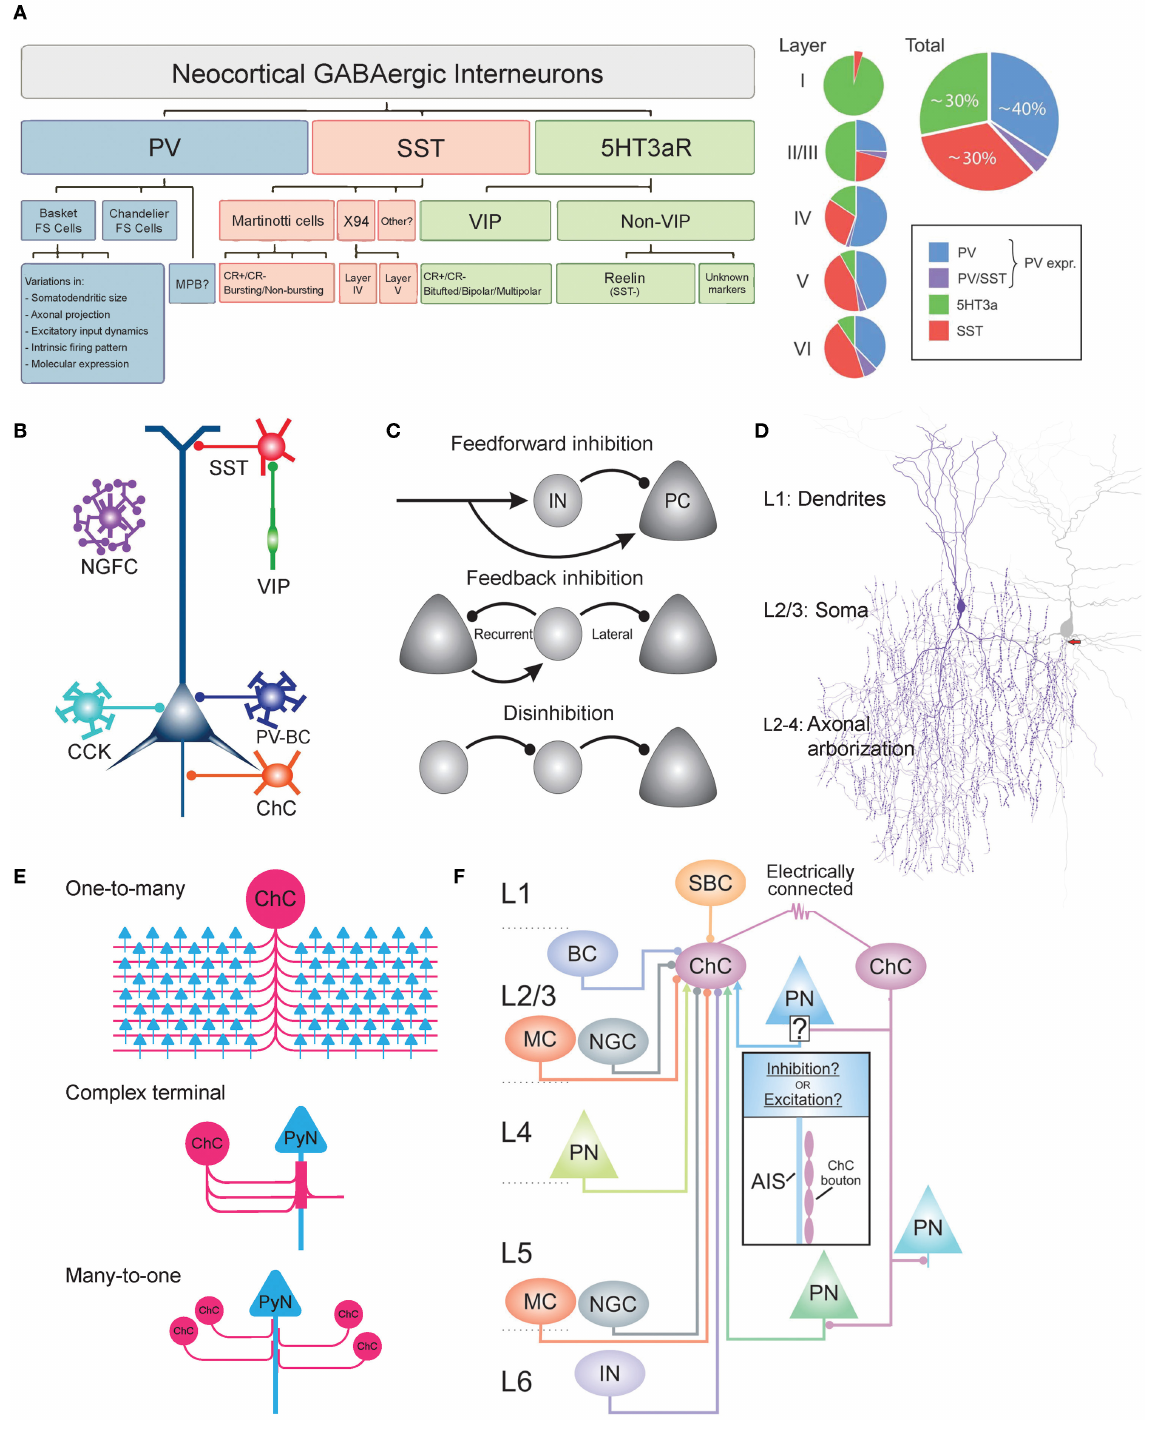
FIGURE1 Heterogeneity of GABAergic interneurons and connectivity of ChCs. (A) Dendrogram and Venn diagram of neocortical GABAergic interneurons. Parvalbumin-expressing interneurons (PV-INs) account for ∼ 40% of all GABAergic interneurons. PV-INs further divide into basket cells, chandelier cells, and multipolar bursting cells (MPBs). Somatostatin-expressing interneurons (SST-INs) account for ∼ 30% of all GABAergic interneurons. The majority of SST-INs are Martinotti cells, which are morphological and electrophysiologically heterogeneous and can